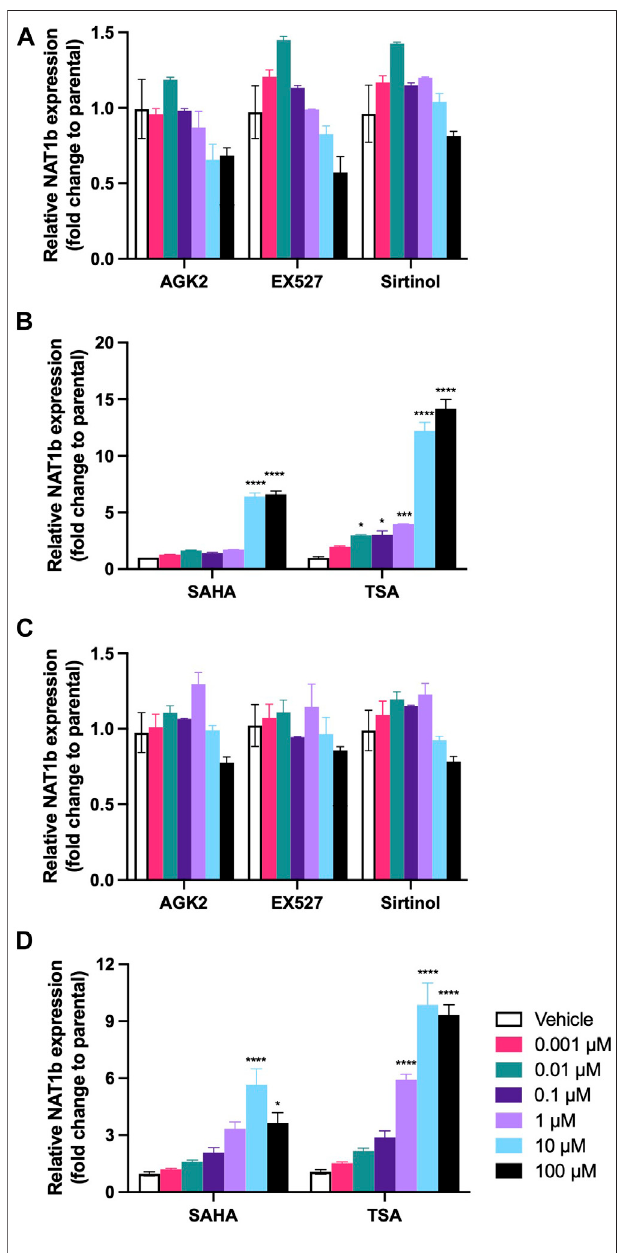
FIGURE 2 | Effect of KDAC inhibition on NAT1b transcription. The relative expression of NAT1b transcript was quanti fi ed in (A) MDA-MB-231 cellstreatedwithAGK2,EX527orSirtinol. (B) MDA-MB-231cellstreatedwith SAHA or TSA. (C) ZR-75-1 cells treated with AGK2, EX527 or Sirtinol. (D) ZR-75-1 cells treated with SAHA or TSA. Data is presented asthe mean ± SEMofthreeindependentexperiments.*, p < 0.05;**, p < 0.01;***, p < 0.001; ****, p < 0.0001 compared vs. vehicle